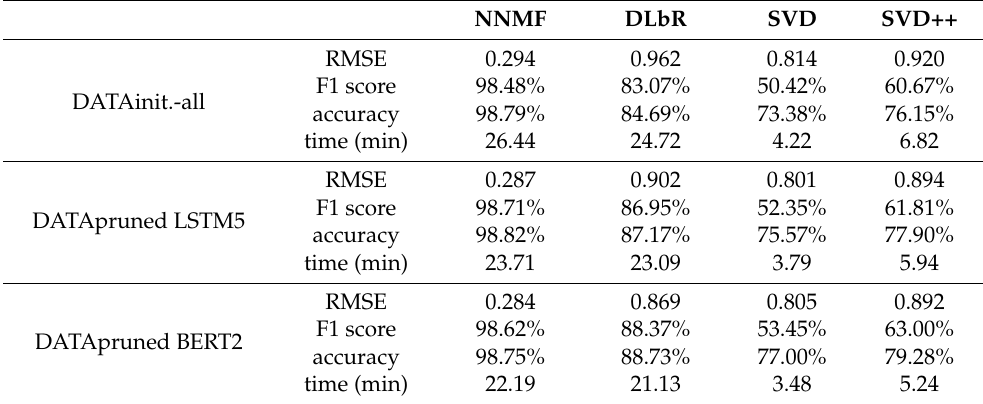
Table 7. Results achieved per each model with three datasets generated from Movies and TV.